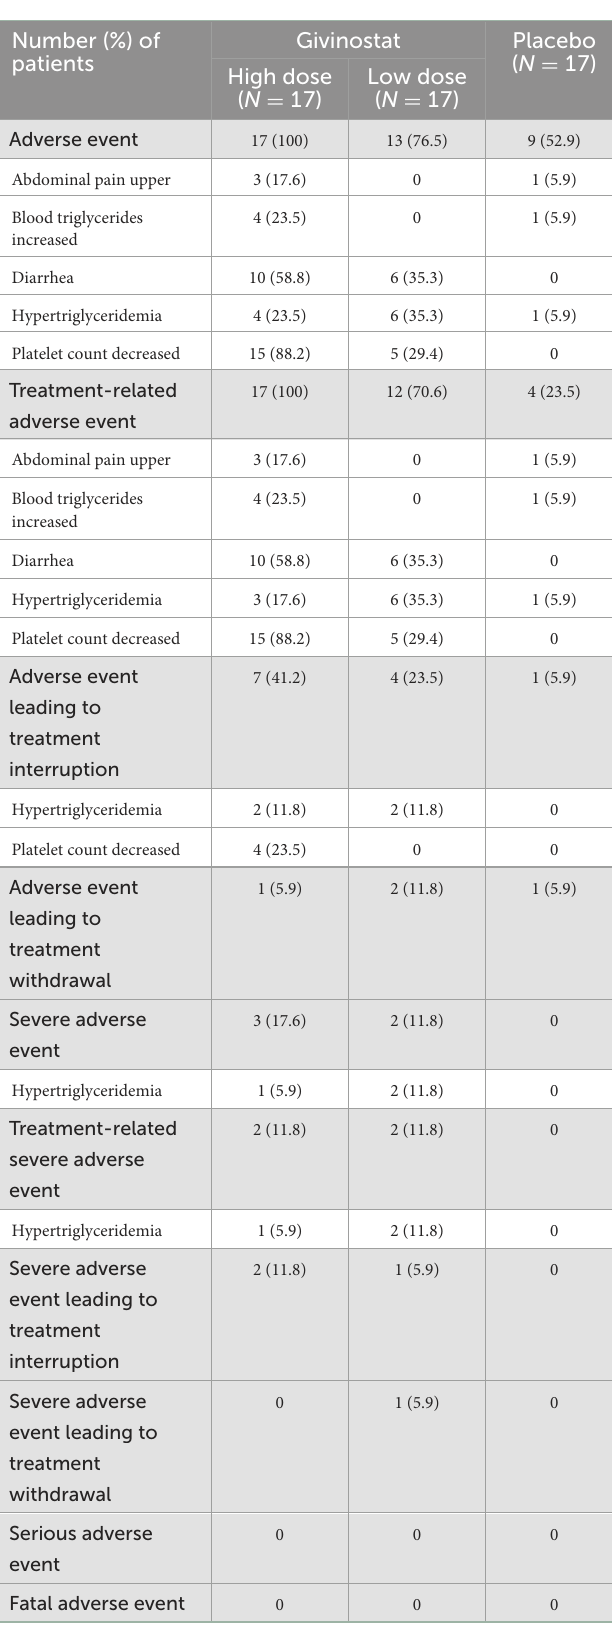
TABLE 5 Adverse events by treatment received at baseline, overall and most common preferred terms ( ≥ 3 patients in any group for adverse events and treatment-related adverse events; ≥ 2 patients in any group for adverse events leading to treatment interruption or withdrawal, and severe adverse